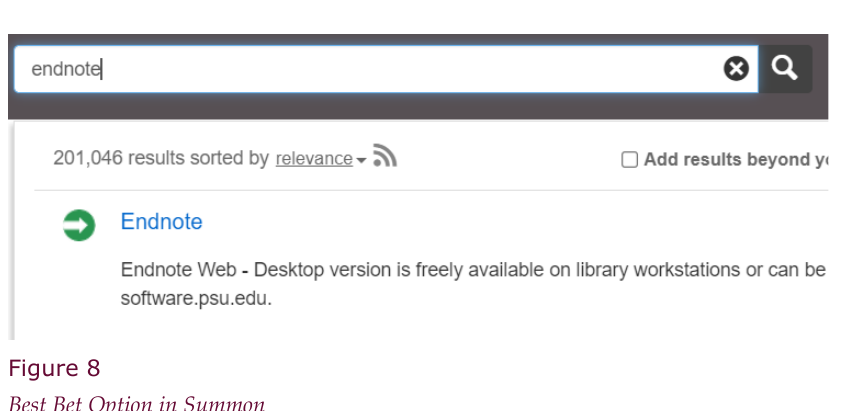
Best Bet Option in Summon